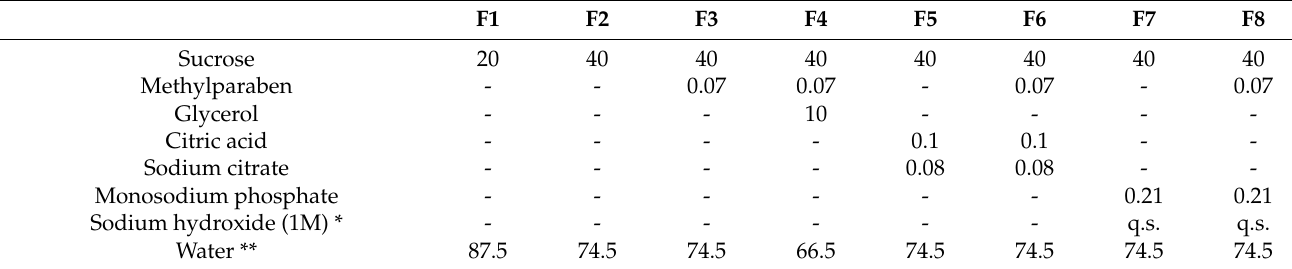
Table 1. Composition (g) of aqueous vehicles intended for the oral delivery of flecainide